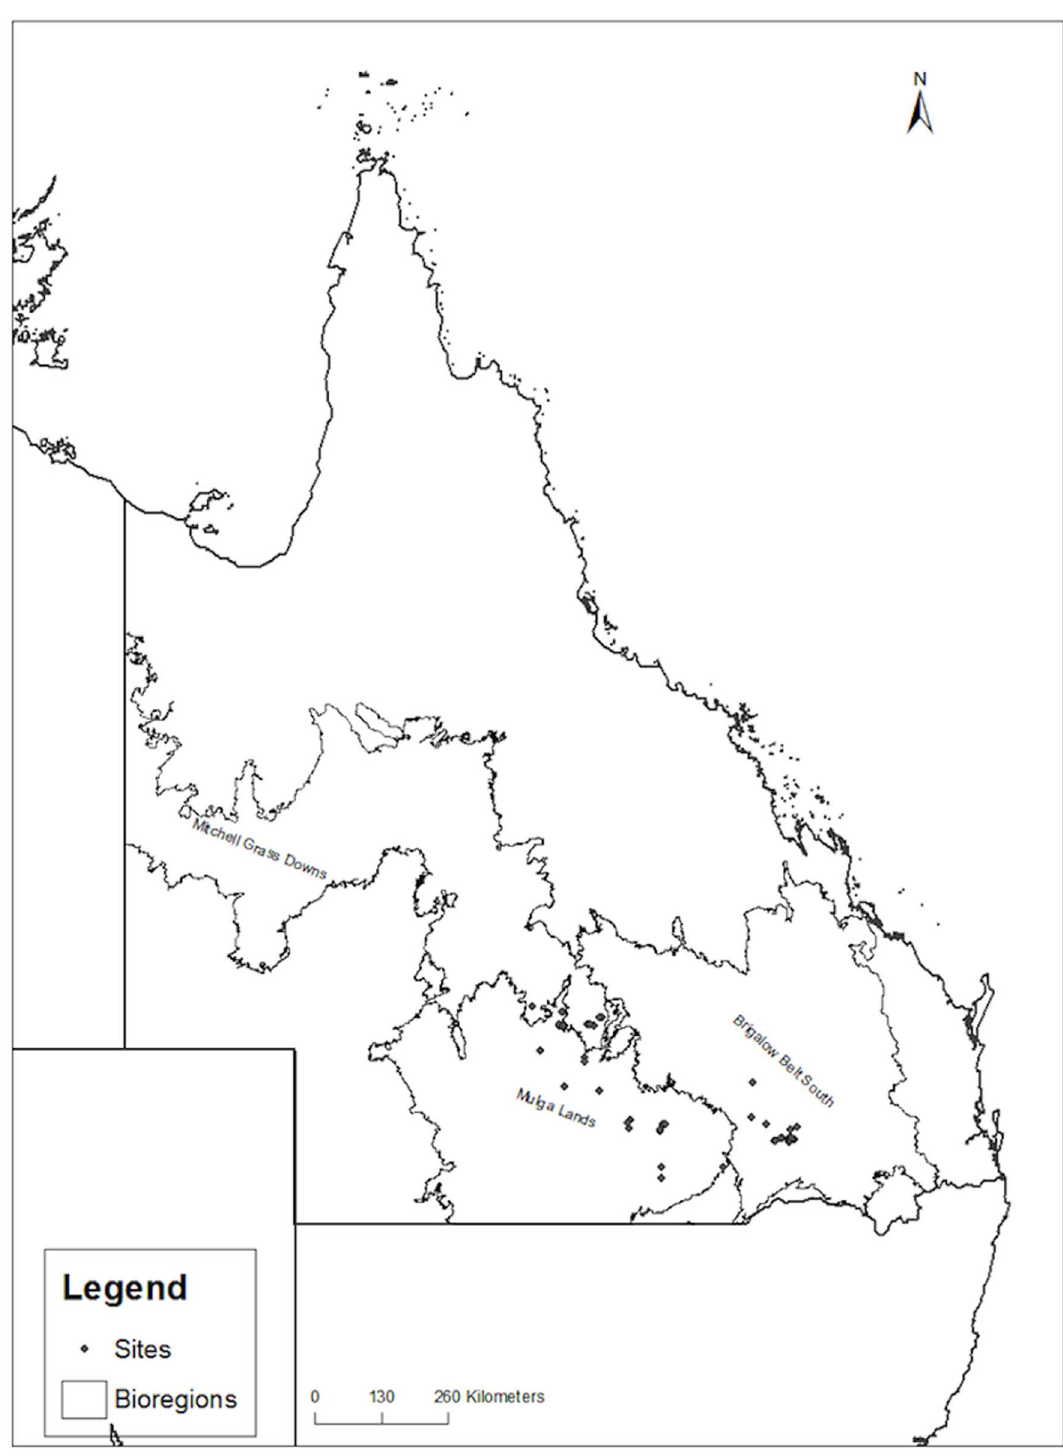
Figure 1. Study area within the Mulga Lands, Mitchell Grass Downs and Brigalow Belt South bioregions, Queensland, Australia. ‘Sites’ denote locations where fresh faecal pellets were collected.